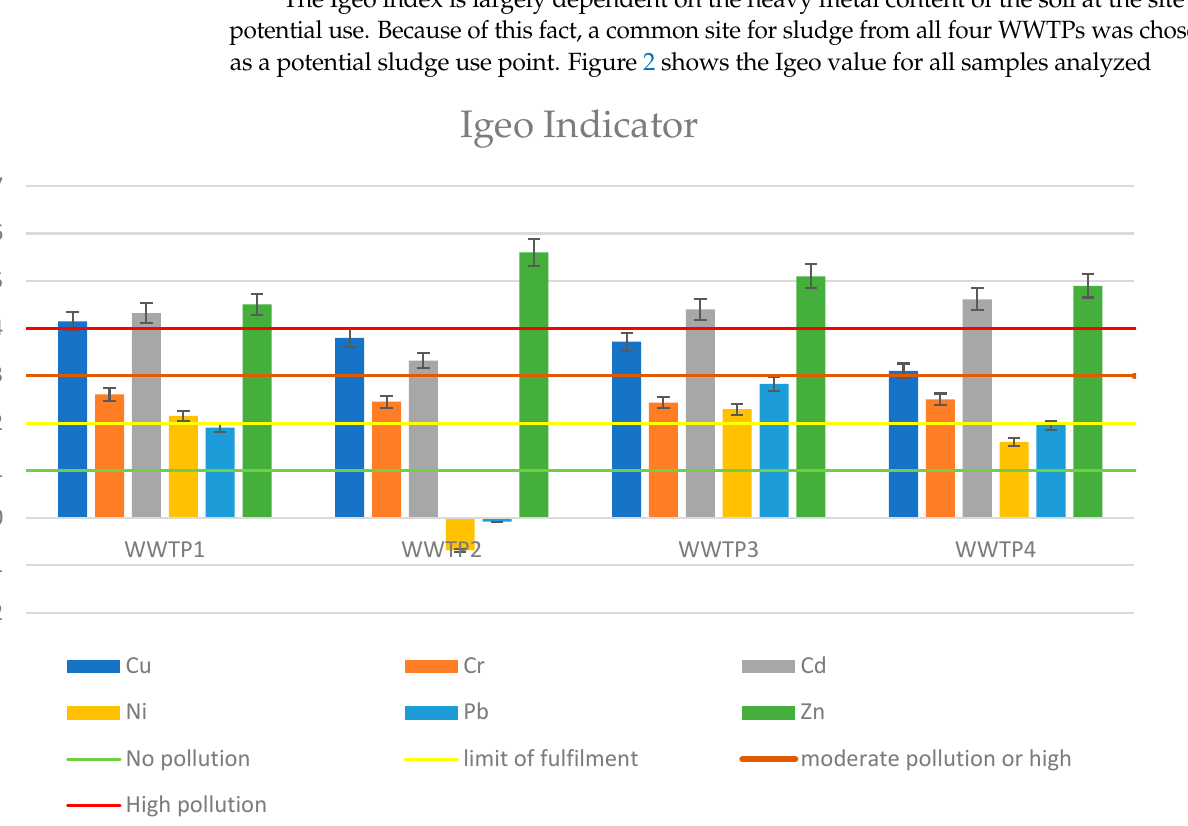
Heavy Metal (mg/kg s.m.)